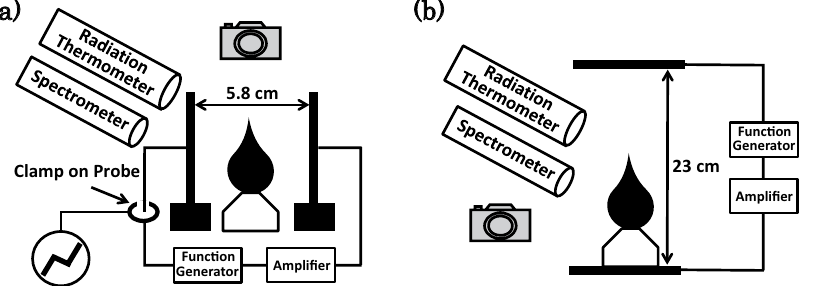
Figure 1. Schematic representation of the experimental configuration is shown, when a strong dc or ac electric field is applied ( a ) horizontally and ( b ) vertically. An ethanol lamp is placed between two stainless-steel electrodes that are arranged at a constant separation distance. A strong dc or ac electric field is applied between the two